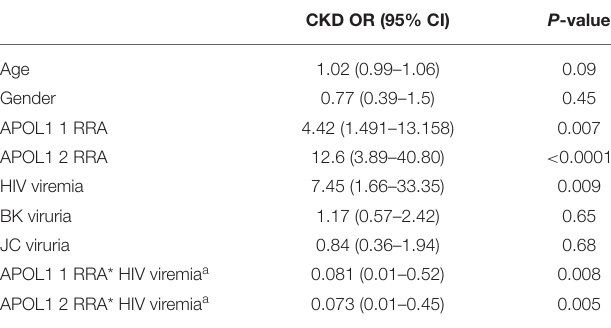
TABLE 3 | Odds ratio (OR) and 95% confidence intervals (CIs) for the association with CKD.